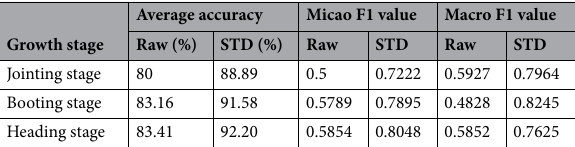
Table 3. Measures for PNN models at different